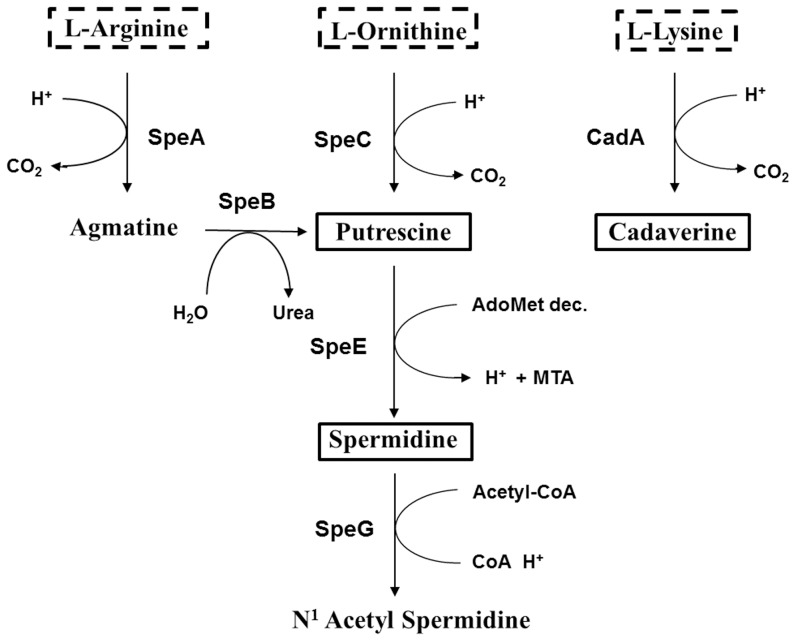
Major steps of the polyamine metabolism in E. coli.The diagram depicts the pathway of polyamine biosynthesis in E. coli. Data are drawn from Ecocyc database [39]. Dotted boxes: precursor aminoacids. AdoMet dec: S-Adenosyl-L-Methioninamine. MTA: S-Methyl-5′-Thioadenosine.